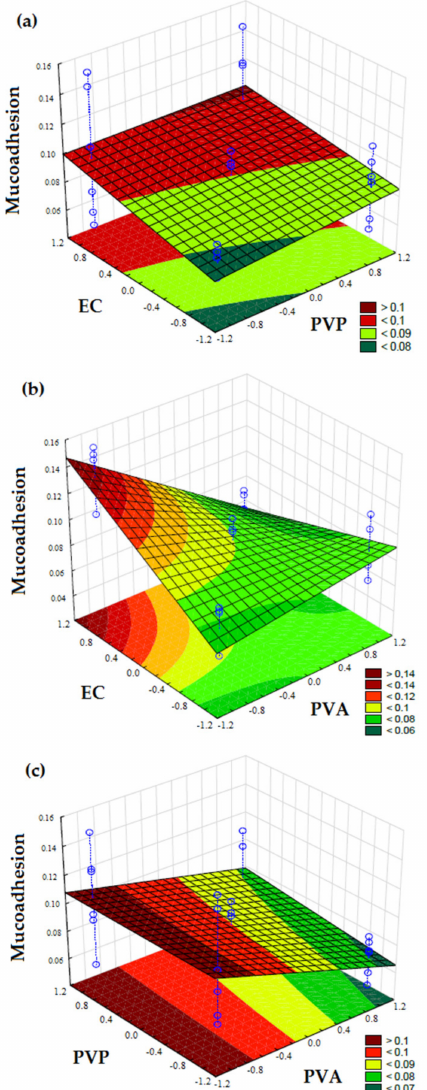
Figure 4. Response surface plots of mucoadhesive force of film formulations as a function of: ( a ) PVP (X 2 ) and EC (X 3 ); ( b ) PVA (X 1 ) and EC (X 3 ); ( c ) PVA (X 1 ) and PVP (X 2 ). The color scale is indicated in each figure and shows the isoparametric